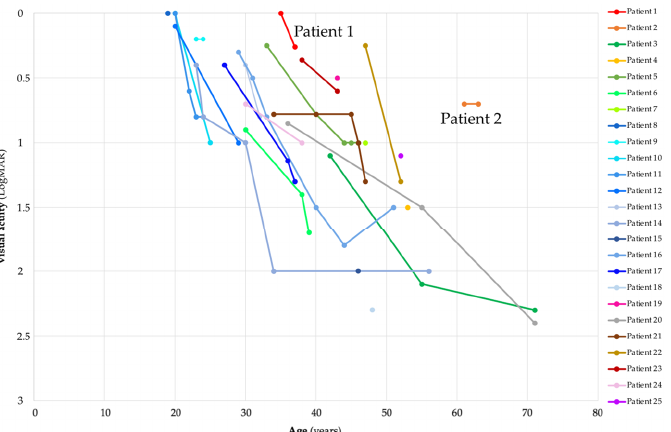
Figure 6. Visual acuity in patients with DRAM2 retinopathy and its worsening through follow-up. Patient 1 (p.Met1?; p.Met1?) had relatively good visual acuity in comparison with other patients harboring two start loss. Patient 2, harboring one missense allele (p.Met1?; p.Leu246Pro), had noticeably better visual acuity in comparison with the other patients. Note that all patients with pathogenic variant p.Gly47Valfs*3 are in the shades of blue. Note that the colors of the patients are the same in Figures 5–8.